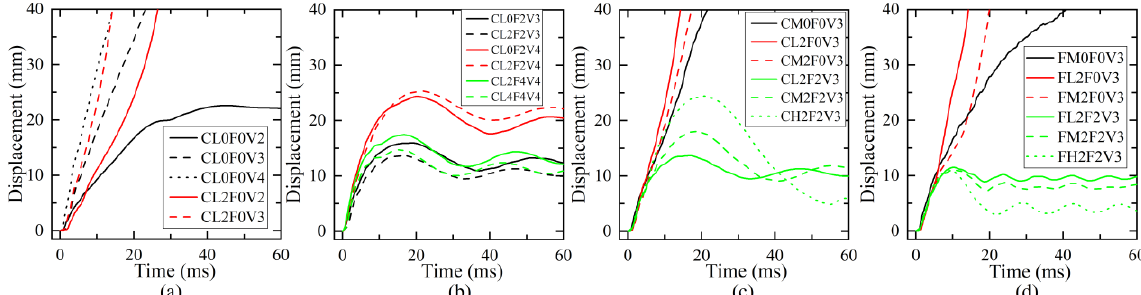
Figure 9. Parametric effects on time histories of lateral displacement: ( a ) impact velocity and axial compression ratio; ( b ) number of CFRP layers and axial compression ratio; ( c ) impact height and number of CFRP layers; ( d ) impact height and number of CFRP layers.